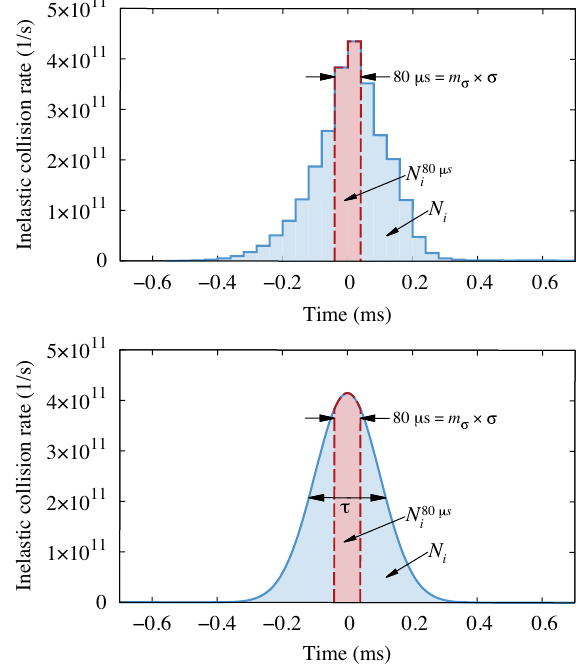
FIG. 7. Measured time profile of a dust event recorded in LHC operation (top) and Gaussian profile used for estimating the loss duration τ (bottom). The standard deviation of the Gaussian distribution was calculated from the relative number of collisions N 80 μ s =N 80 μ s time window. The i contained in the central i relative number of collisions in this interval was estimated from the measurements (ratio of red area and total area in top